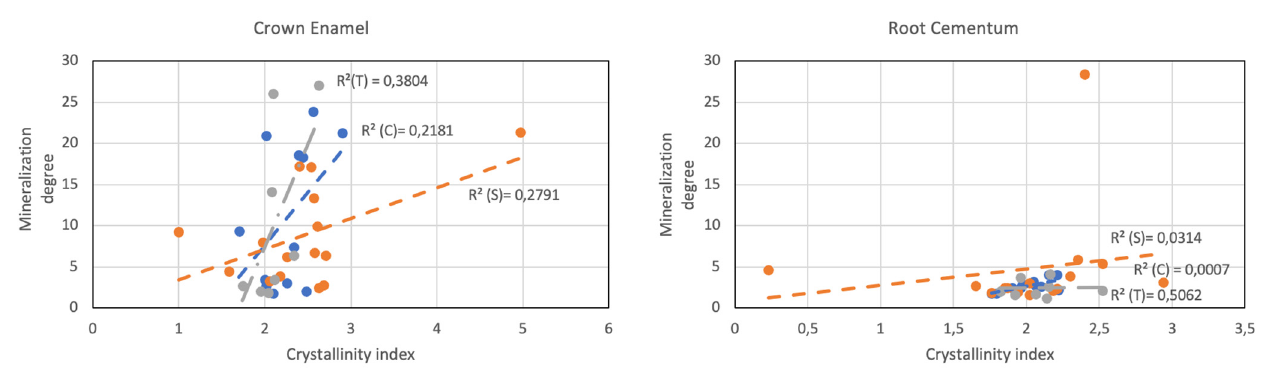
Figure 1. Plots of mineralization degree versus crystallinity index degree for crown enamel and root cementum samples divided into three groups: control (C); smokers (S); and under medical treatment (T) and/or with habits that favored pH changes.